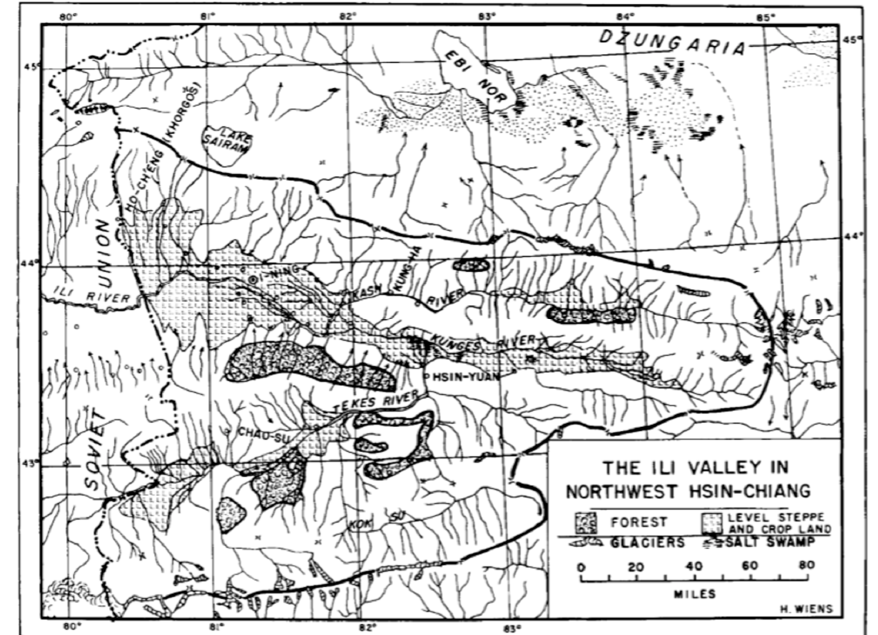
Figure 1. Detailed map of the Chinese portion of the Ili River basin showing the spatial relationship between steppe lands that are suitable for crops, the region’s major rivers and other geographical features. The Ili, Kash, Tekes and Künes (here designated as Kunges) rivers are identified, as is the border with the Soviet Union. Note the large number of smaller tributary streams. The map was drawn prior to the large scale irrigation and land reclamation efforts of the late 20th and early 21st centuries and is used with permission of the copyright holder [37].